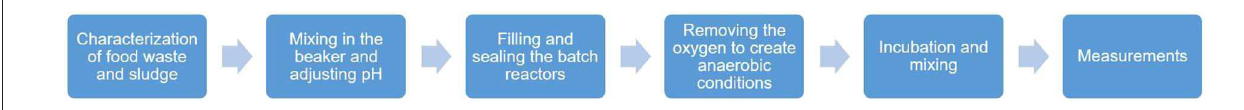
FIGURE 2 | Laboratory protocol of the investigated system.